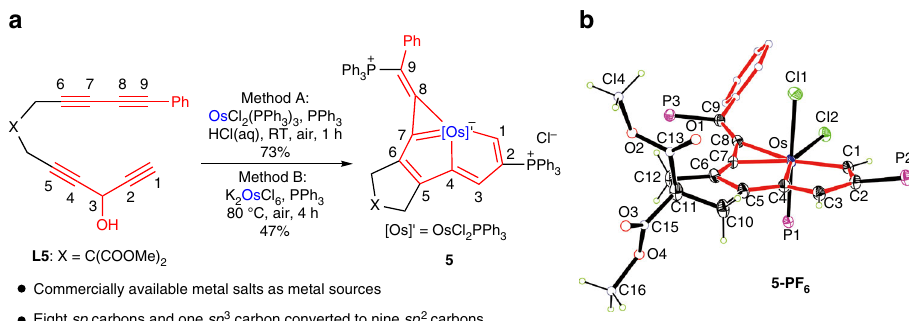
Fig. 3 Synthesis of a CCCC-type chelate from tetrayne and alternative metal sources. a Tetrayne as ligand precursor to access a CCCC-type chelate. b X- ray structure of the cation of 5-PF 6 drawn with 50% probability (phenyl groups in PPh 3 are omitted for clarity). Selected bond distances (Å) and bond angles (deg): Os – C1 2.041(3), Os – C4 2.082(3), Os – C7 2.003(3), Os – C8 2.132(3), C1 – C2 1.385(5), C2 – C3 1.413(5), C3 – C4 1.378(5), C4 – C5 1.416(5),